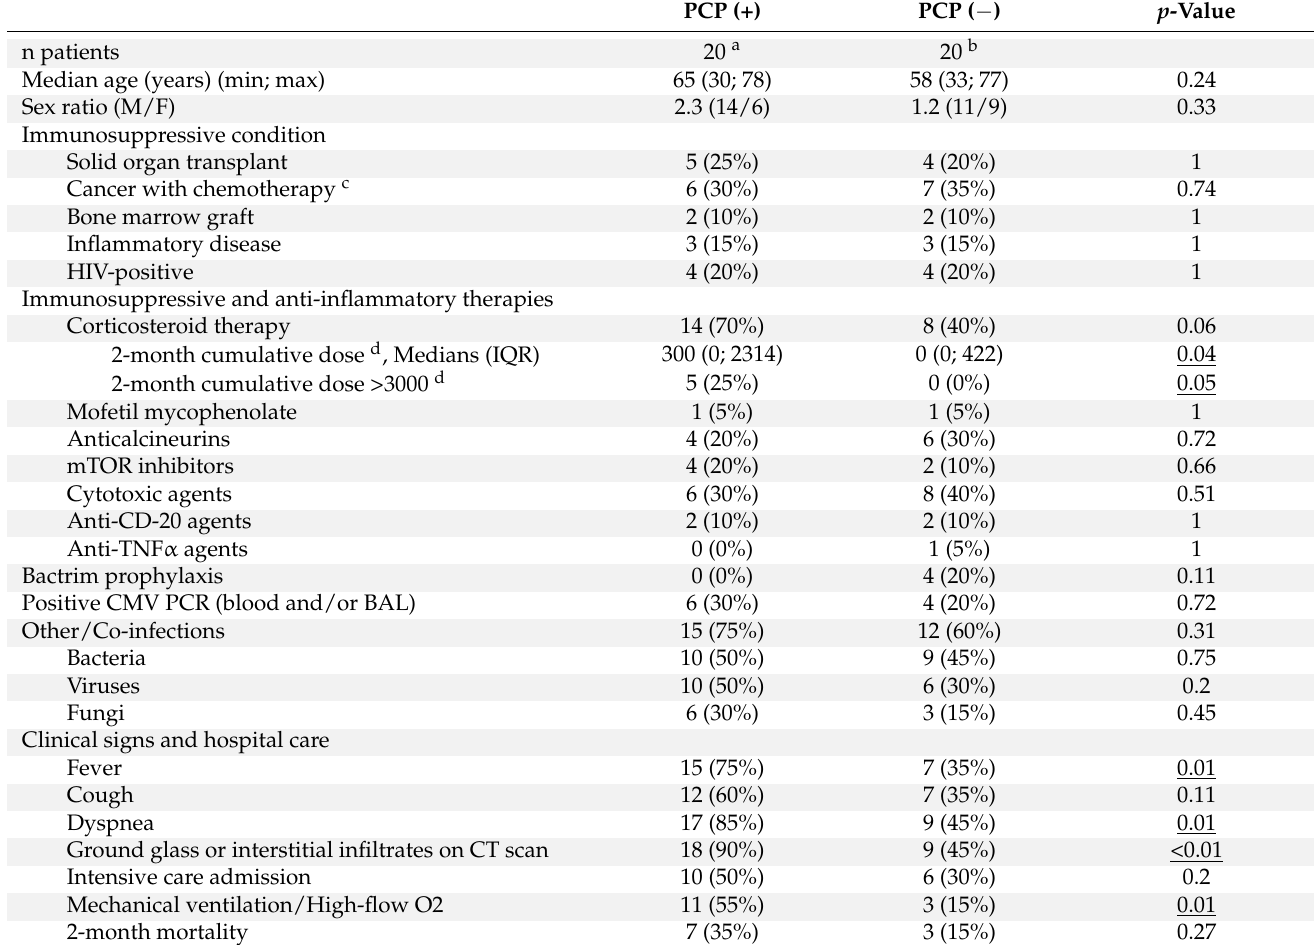
Table 1. Clinical and demographic characteristics of PCP positive and negative